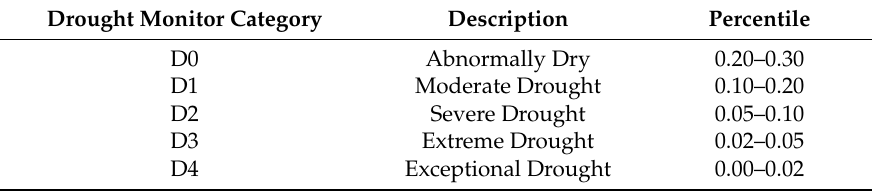
Table 3. Drought monitor categories 1